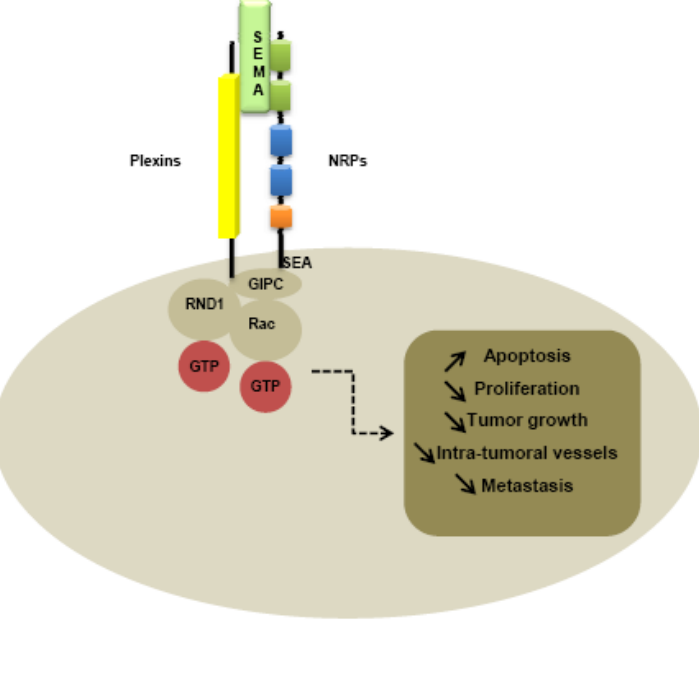
Figure 3. NRPs cooperate with class 3 semaphorins and plexins in endothelial and cancer cells.